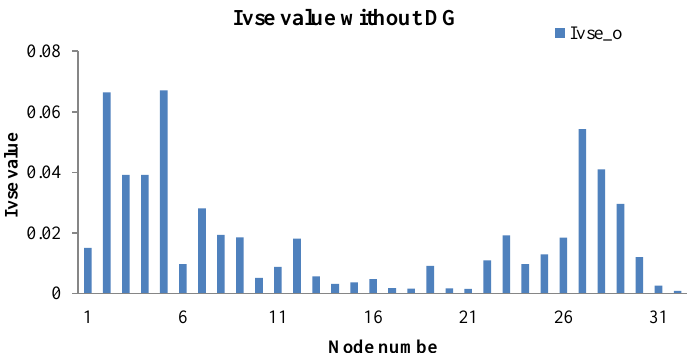
Figure6. Thevoltagestabilityevaluationindex( Ivse )initialvaluewithoutDG.(DG:distributedgeneration). Figure 6. The voltage stability evaluation index ( Ivse ) initial value without DG.(DG: distributed generation). Table 3. Index value of Ivse without electric vehicle. Table 3. Index value of Ivse without electric vehicle.